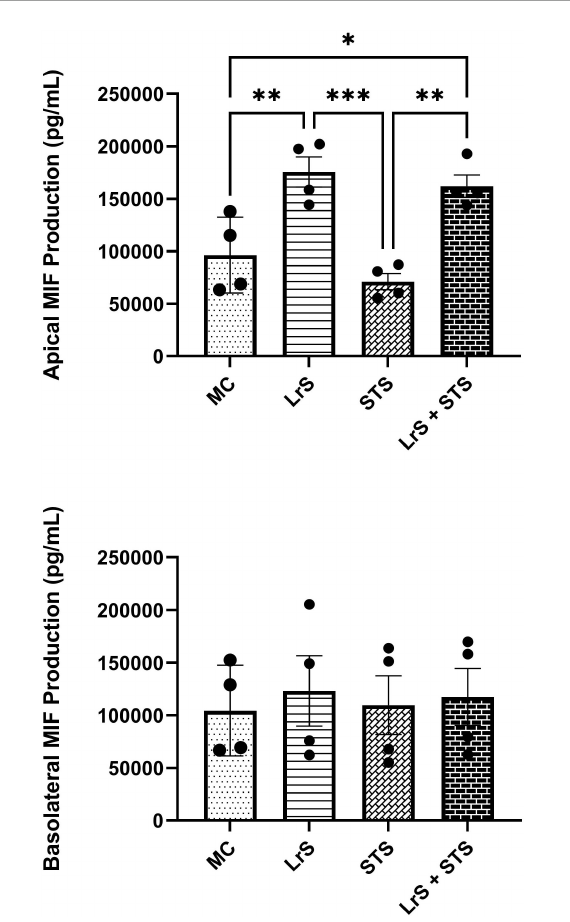
FIGURE2 Apical and basolateral production of MIF by T84 IEC and THP-1 monocyte co- cultures following challenge with the LrS, STS, or a combination of the secretomes for 24 h. Data shown is the mean cytokine/chemokine production (pg/mL) ± SEM ( n = 4). Significance is indicated as ∗ p < 0.05, ∗∗ p < 0.01, ∗∗∗ p < 0.001 as determined by one-way ANOVA and Tukey’s post-hoc test.